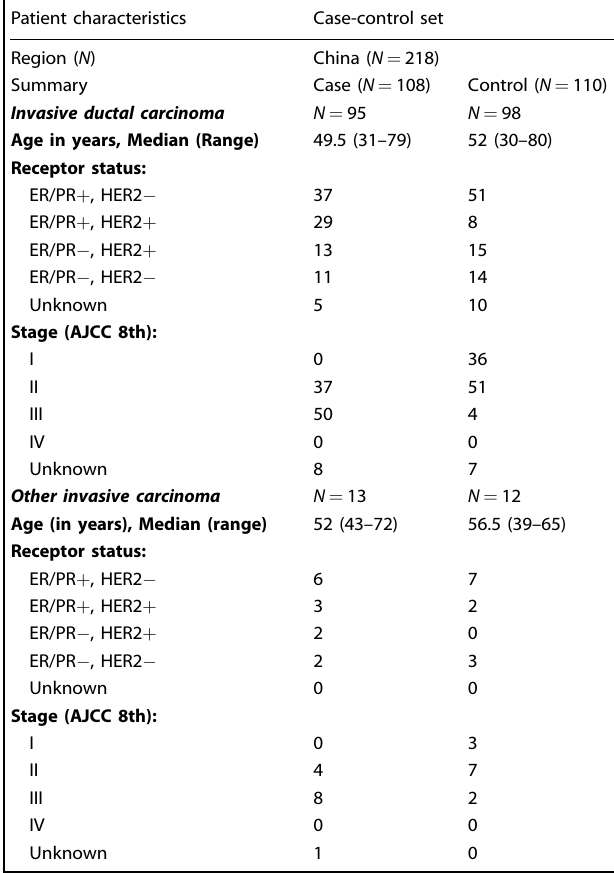
biopsies 15,29 – 31 . We have also reported the identi fi cation of methylated gene marker panels which are speci fi c to preinvasive